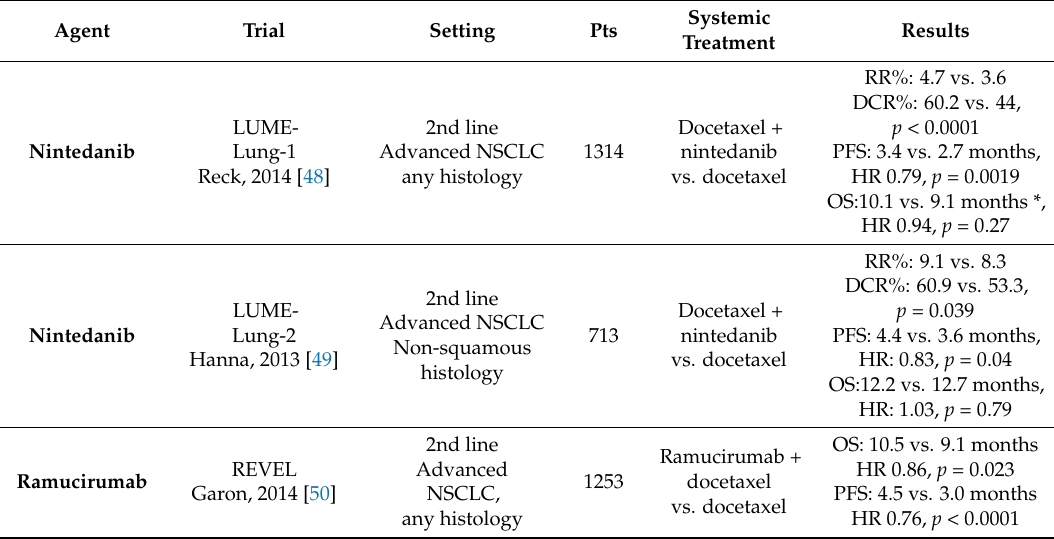
Table 3. Randomized phase III clinical studies with nintedanib and ramucirumab in NSCLC. Agent Trial Setting Pts